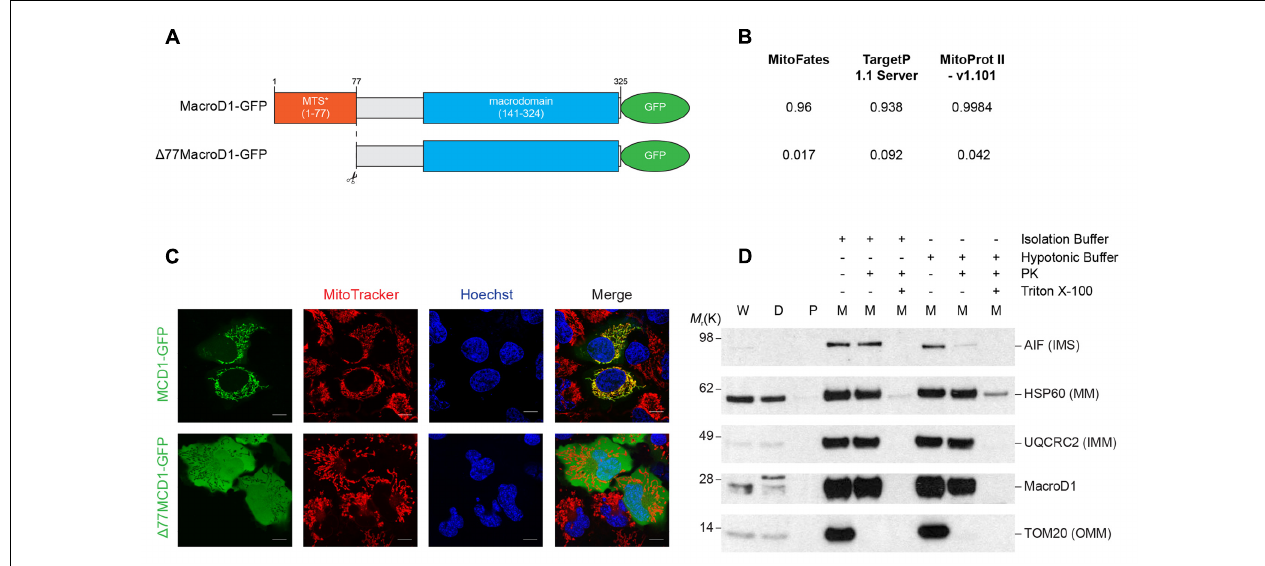
FIGURE 3 | The N-terminus of MacroD1 is required for mitochondrial localization and import. (A) Schematic diagram of full-length MacroD1 (MacroD1-GFP) and N-terminal truncated MacroD1 ( (cid:49) 77MacroD1-GFP) constructs. MTS ∗ – Predicted mitochondrial targeting sequence was ascribed using the MTS cleavage site as predicted by MitoFates, located between amino acid 77 and 78 (Fukasawa et al., 2015). (B) MTS probability prediction scores for MacroD1-GFP and (cid:49) 77MacroD1-GFP cDNA sequences using MitoFates (Fukasawa et al., 2015), TargetP 1.1 Server (Emanuelsson et al., 2000) and MitoProt II – v1.101 (Claros and Vincens, 1996). (C) Live cell imaging of U2OS cells transfected with MacroD1-GFP (green) or (cid:49) 77MacroD1-GFP (green) for 48 h; mitochondria and nuclei were labeled with MitoTracker Deep Red FM (red) and Hoechst 33258 (blue), respectively. (D) Isolated mitochondrial fractions from HeLa cells were resuspended in isolation buffer or hypotonic buffer (2 mM HEPES) before treatment with proteinase K (PK) and/or Triton X-100 (as indicated). Immunoblot analysis was performed to determine PK accessibility to MacroD1 and sub-mitochondrial protein markers: AIF [apoptosis-inducing factor 1, mitochondrial; intermembrane space (IMS) marker, HSP60 (60 kDa heat shock protein, mitochondrial; mitochondrial matrix (MM) marker], UQCRC2 [cytochrome b-c1 complex subunit 2, mitochondrial; inner mitochondrial membrane (IMM) marker] and TOM20 [mitochondrial import receptor subunit; outer mitochondrial membrane (OMM)] marker. W, whole cell extract; D, cell debris; P, post mitochondrial supernatant; M, isolated mitochondrial